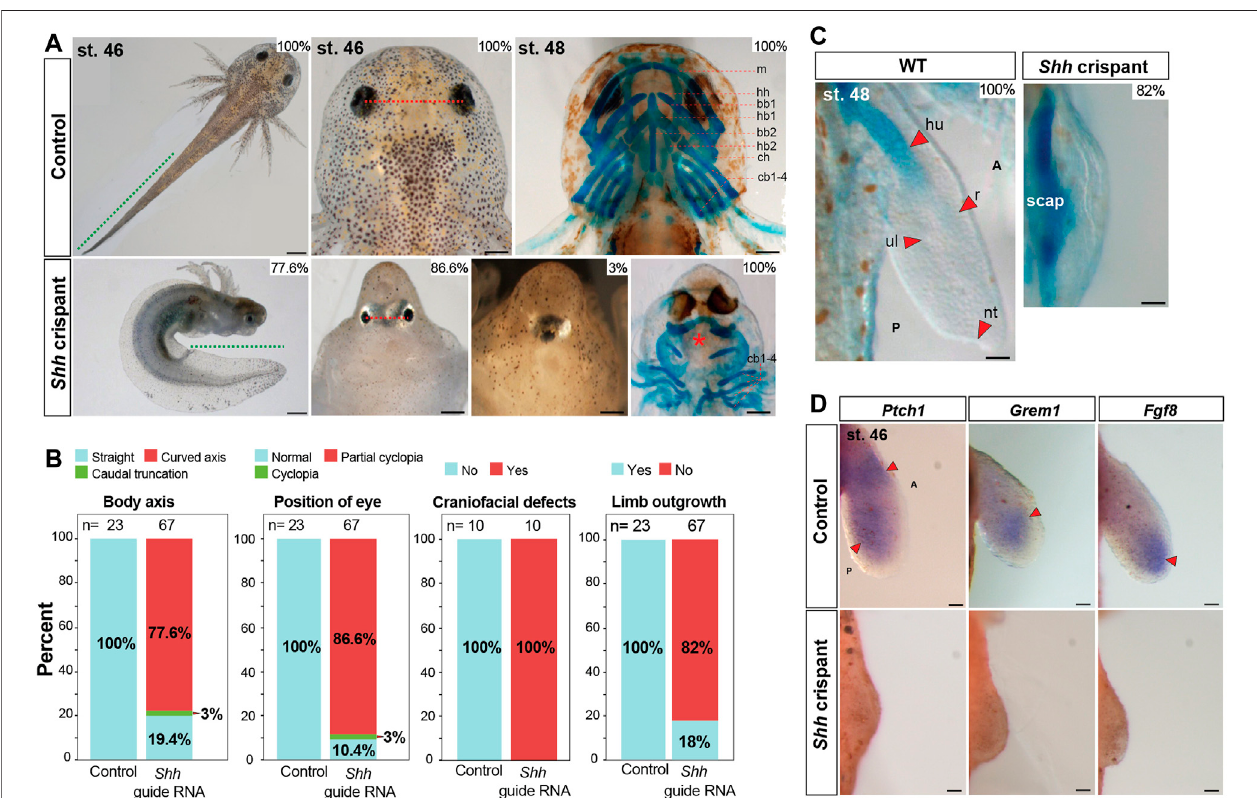
FIGURE2| Axolotl Shh crispantscompletelylackforelimbs. (A,B) Phenotypeslikebodyaxis,positionoftheeye,andAlcianblue/Alizarinredstainingofcraniofacial structuresofCRISPRcontroland Shh crispantlarvae( n =23forCRISPRcontroland n =67for Shh crispantlarvaeforbodyaxisandeyepositionanalysis, n =10eachfor CRISPRcontroland Shh crispantlarvaeforAlcianblue/Alizarinredstainingofcraniofacialstructures).Greendottedline,taillength;reddottedline,distancebetweenthe eyes; red asterisk, loss of anterior cranio-facial structures. Scale bar = 1 mm (for body axis) and 500 µm (for eye position and cranio-facial structures). (B,C) Alcian blue/Alizarinredstainingforstage48limbsofCRISPRcontroland Shh crispantlarvae( n =10).Scalebar=500 µm. (D) Insitu hybridizationforgenes Ptch1 , Grem1 ,and Fgf8 in CRISPR control and Shh crispant larvae at stage 46 limbs ( n = 3 or 4 per treatments). Red arrows, expression domains. Scale bar = 100 µm. m, meckel; hh, hypohyale; bb1, basibranchial 1; hb1, hypobranchial 1; bb2, basibranchial 2; hb2, hypobranchial 2; ch, ceratohyal; and 4 cb1-4, ceratobranchials.